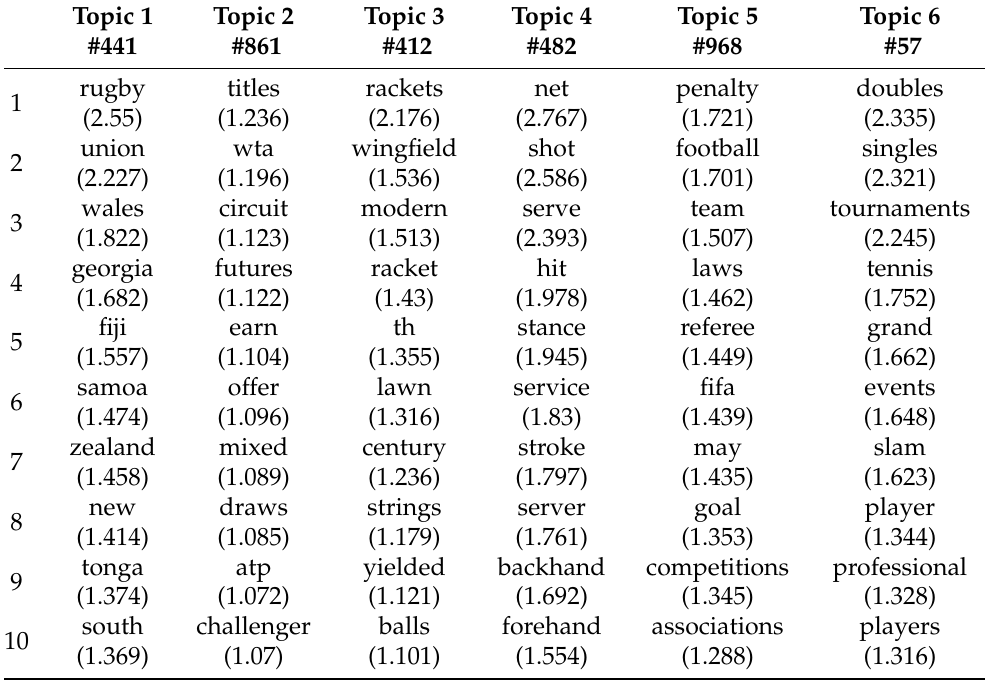
Table A8. Each column lists the top 10 representative words per dimension of the basis matrix A .